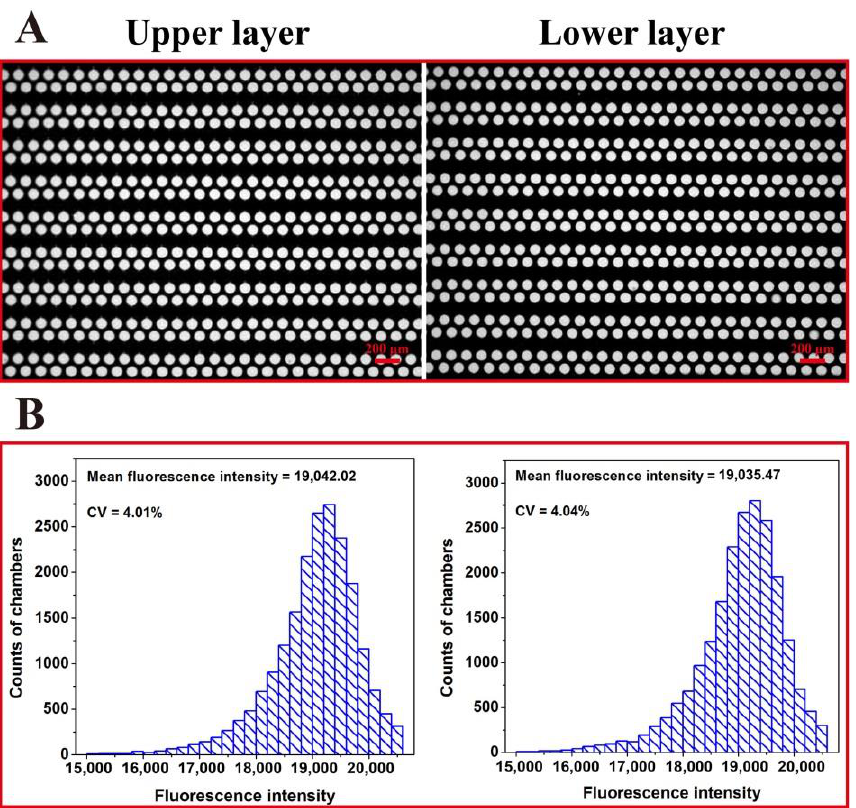
Figure 3. Fluorescent image of the upper and lower ( A ) arrays after loading fluorescence reagent, and uniformity analysis of the dPCR chip ( B ).